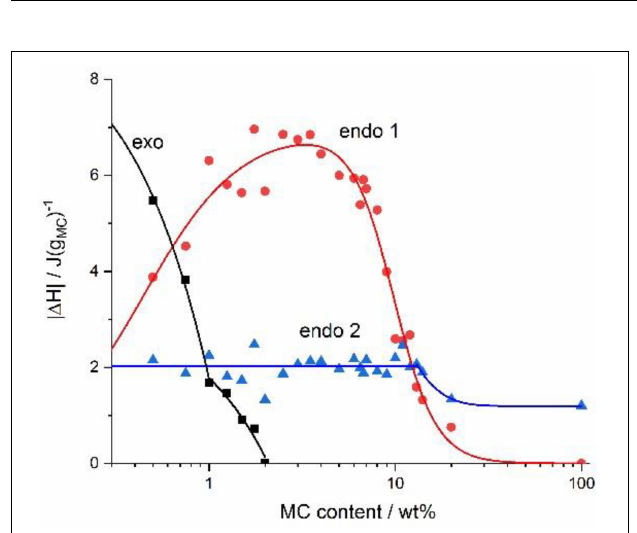
FIGURE 5 | (A) Schematic illustrating the thermogelation of methylcellulose, as adapted from Wang et al. (2019). Reproduced with permission from John Wiley and sons. (B) Chemical structure of methylcellulose.